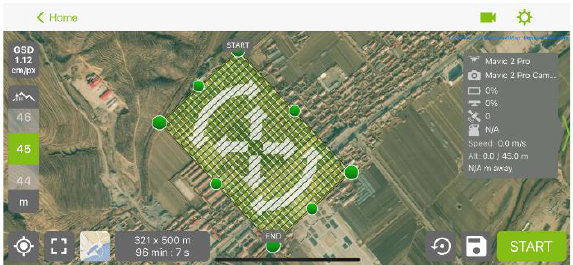
Figure 5. the Double grid flight mode